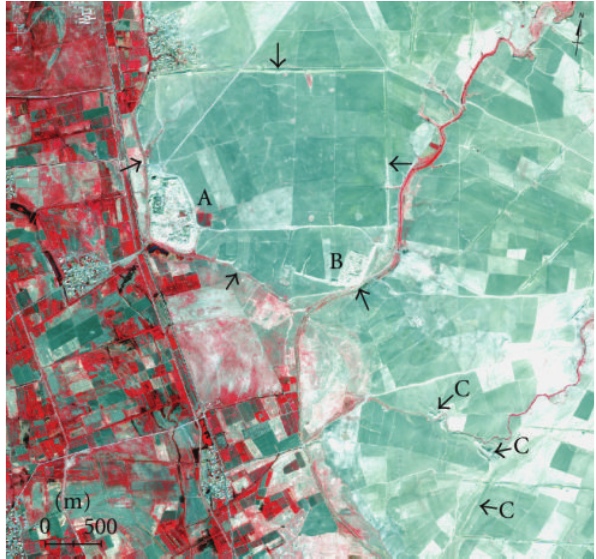
Figure 7: Kalhu in a pan-sharpened (bands 4-3-2) Ikonos-2 image of 2007: (A) Tell Nimrud; (B) Fort Shalmaneser; (C) traces and remains of the Assyrian canal identified with the Patti-nuˇsi ; big arrows show traces and remains of the city walls.